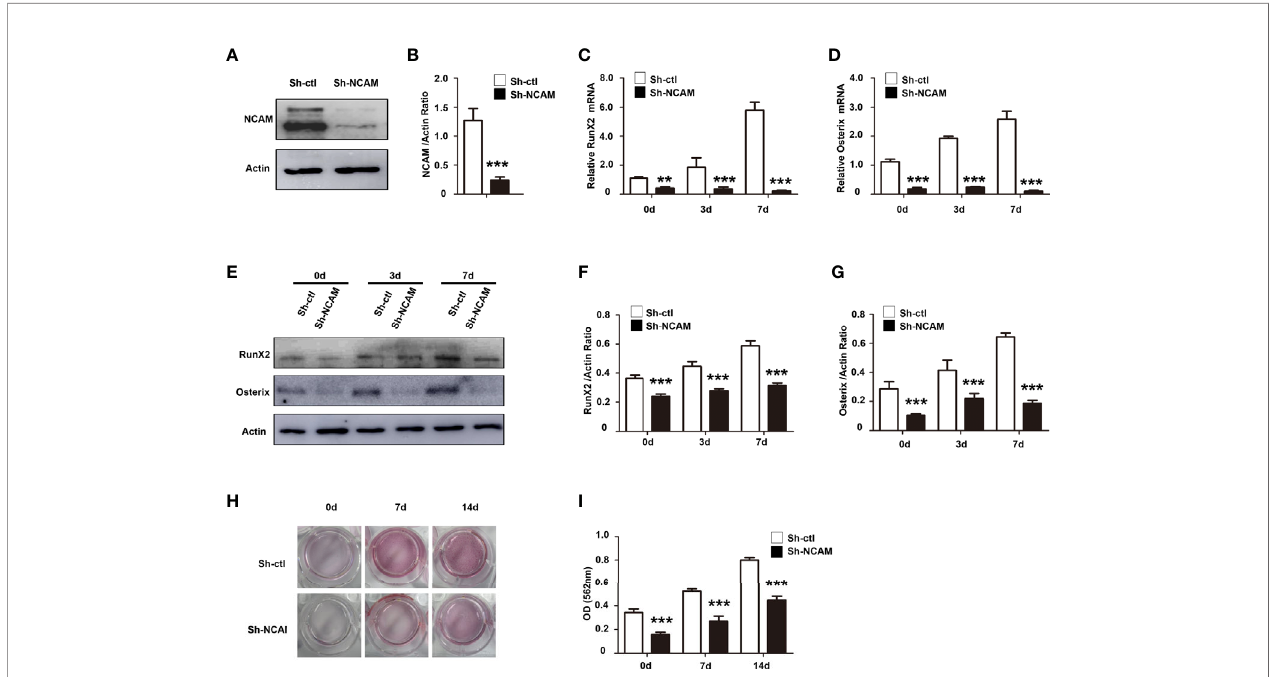
FIGURE 1 | NCAM silencing inhibits osteoblast differentiation of preosteoblast-like MC3T3-E1 cells. (A) Cells were transfected with pSilencer-4.1-based plasmid containing a scrambled sequence (control; Sh-ctl) or a 19-bp oligonucleotide insert targeting mouse NCAM (Sh-NCAM), and analysed by immunoblotting with anti- NCAM antibody. (B) Level of NCAM was quanti fi ed by densitometry and normalized to b -actin (n=3; mean ± SEM; *** p < 0.001, compared with control siRNA group). The expression of RunX2 (C) and Osterix (D) was analysed by real-time PCR (The results are expressed as the mean ± SEM of three independent experiments. ** p < 0.01, *** p < 0.001, compared with control siRNA-transfected cells). (E) The expression of RunX2 and Osterix was analysed by immunoblotting, b -actin was detected as a loading control. Levels of (F) RunX2 and (G) Osterixwere quanti fi ed by densitometry and normalized to b -actin (Data are representative of three independent experiments and values are means ± SEM. *** p < 0.001, compared with control siRNA-transfected cells). (H) Cells transfected with control or NCAM siRNA were induced with osteoblastic media and stained with Alizarin red. (I) The Alizarin red staining was extracted and quanti fi ed, the wavelength was measured at 562 nm (Data are representative of three independent experiments and values are means ± SEM. *** p < 0.001, compared with control siRNA- transfected